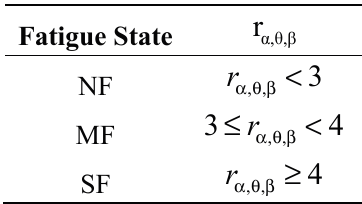
Table 2. EEG detection based fatigue